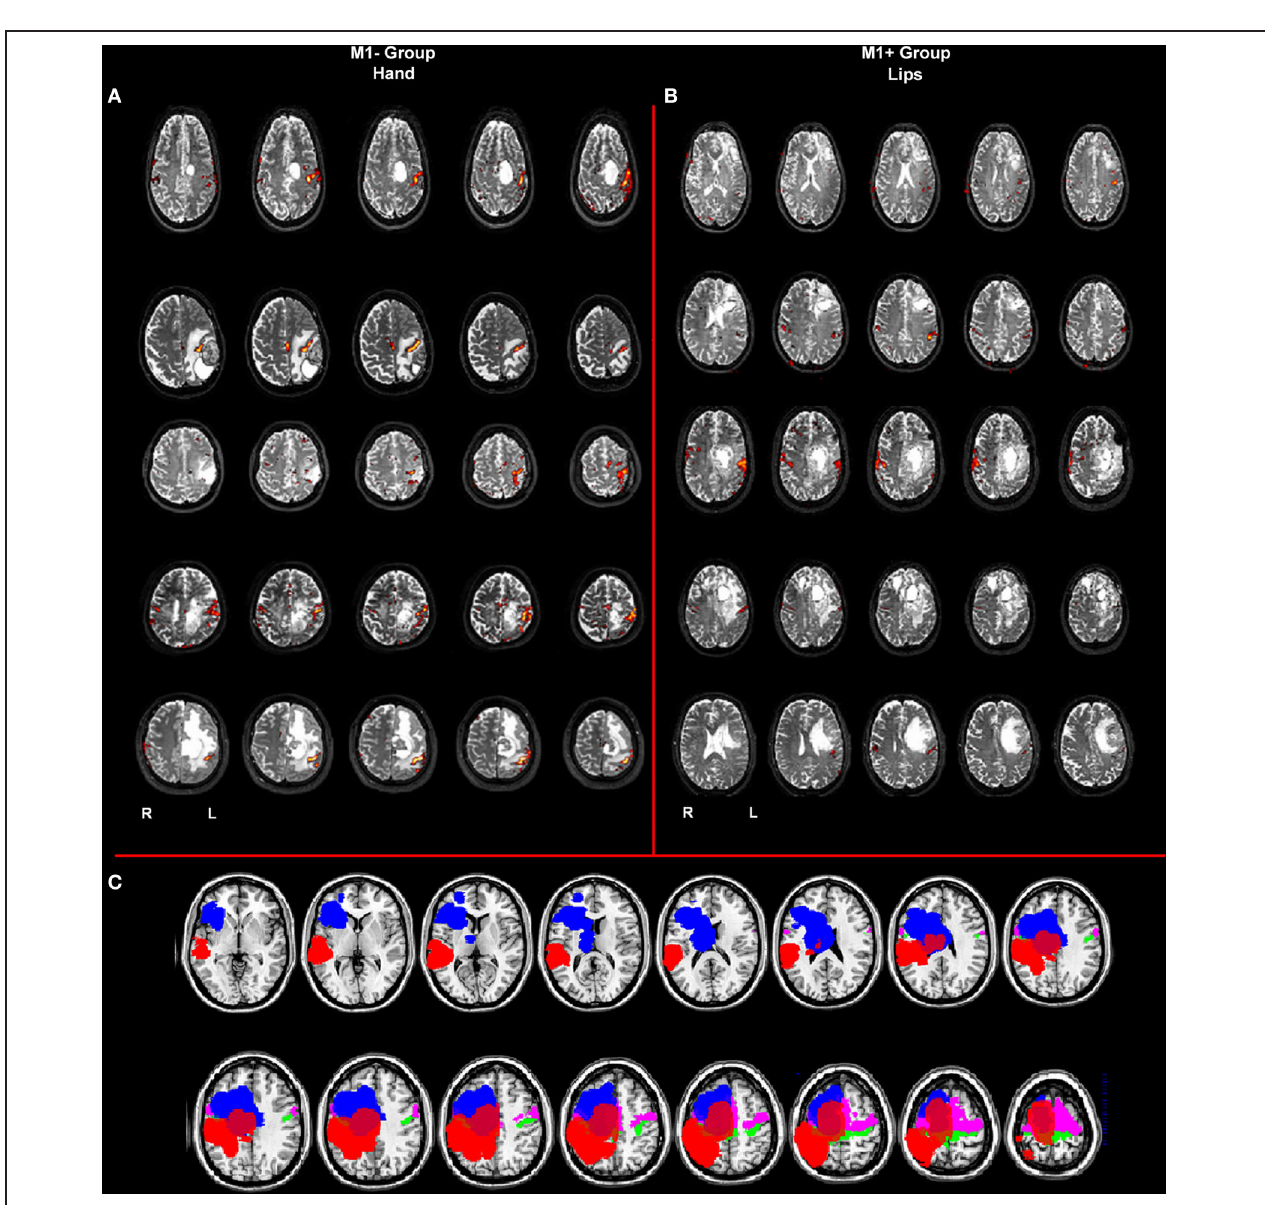
the M1 + to the lip representation area, as evidenced by the activation cluster. Data were thresholded at p < 0 . 05 cluster corrected ( Z > 2 . 3). (C) Overlapping of the ROIs drawn on the patients’ lesions after normalization (in blue for the M1 + and in red for the M1 − ) and of the mask created by using the Anatomy Toolbox and the maximum probability maps (MPS) of the left and right M1 (in green) and of the left and right Pm cortex (in pink).